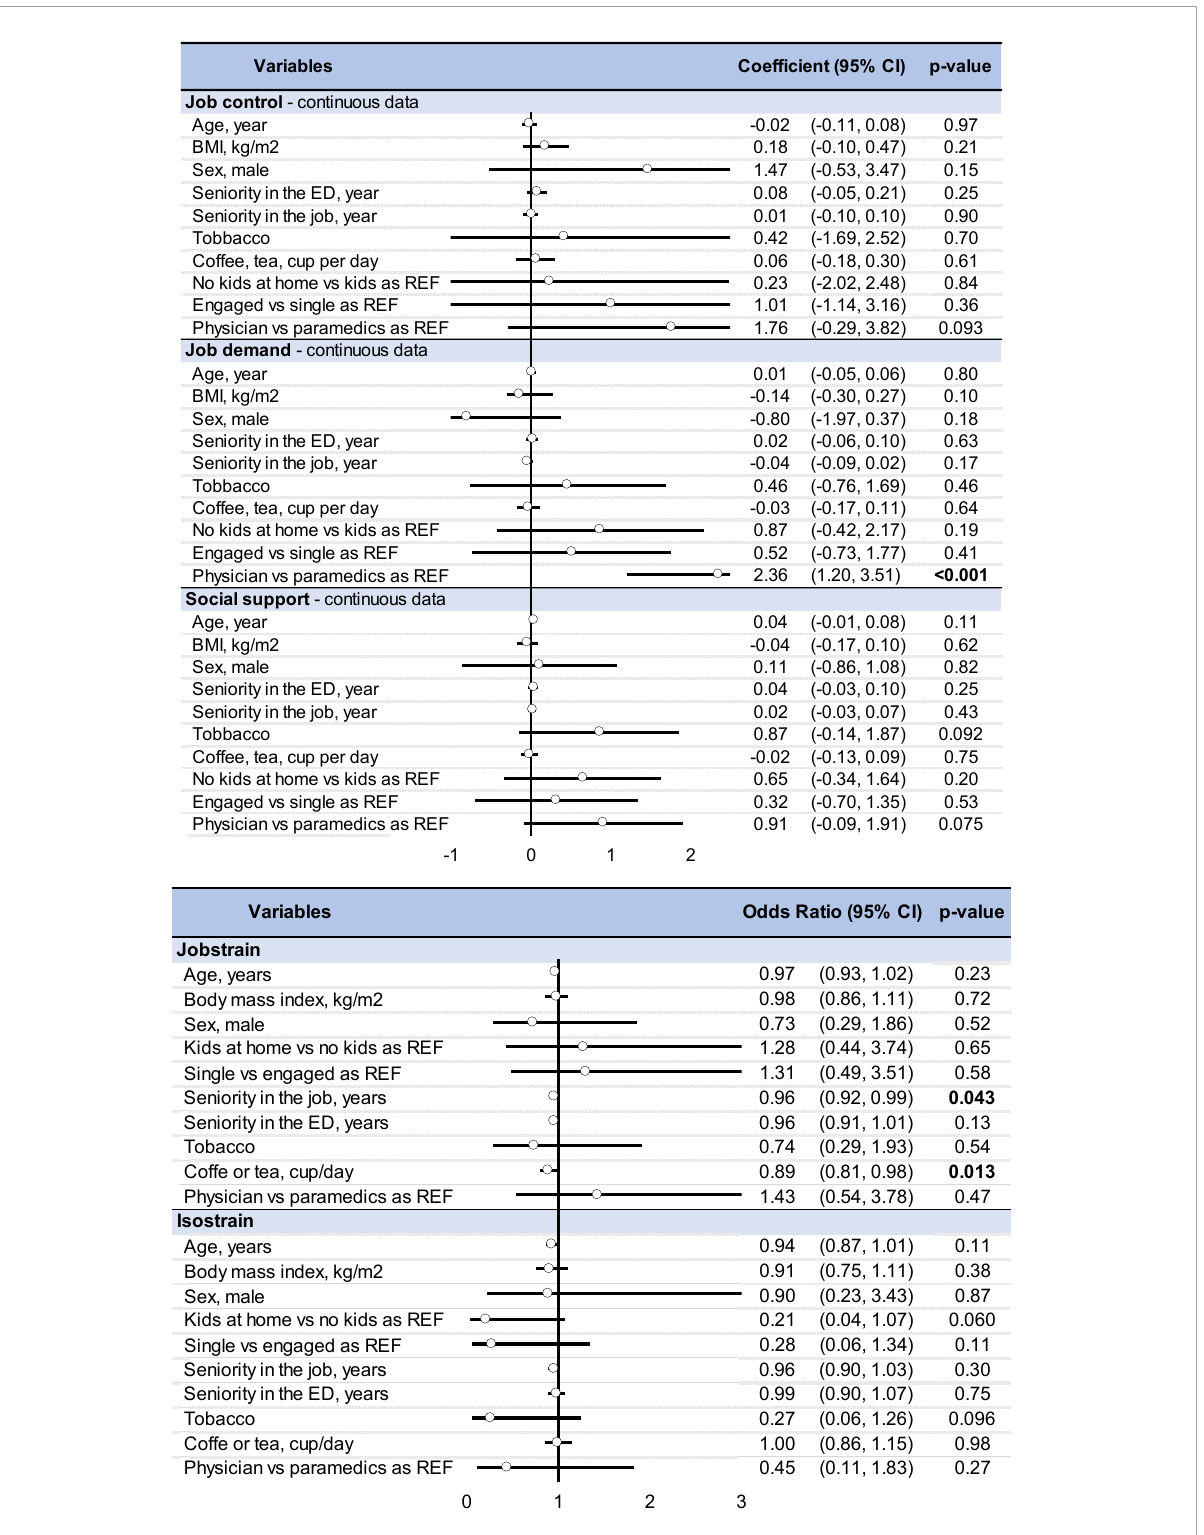
FIGURE6 Impact of sociodemographic characteristics on quantitative data (job control, job demand, and social support) and qualitative data (job strain and isostrain). Results about quantitative data are a coefficient and those about qualitative data are in odds ratio. Bold values means significant